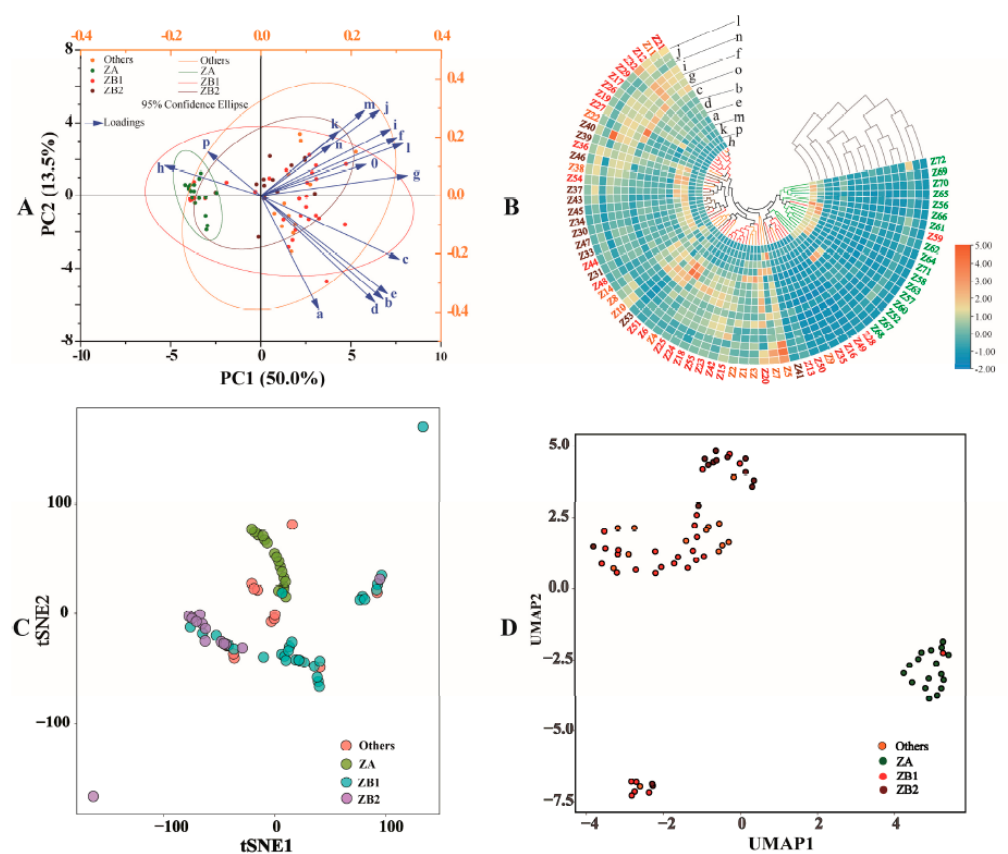
Figure 2. Geographical differentiation of prickly ash pericarps from 72 plantations based on the volatile oil profile of pericarps: ( A ) principal component analysis, ( B ) cluster heat map, ( C ) t-distributed stochastic neighbor embedding, ( D ) uniform manifold approximation and projection for dimension reduction. Sample codes or spots with the same colors represent the samples that belong to the same group; PC, principal component; ZA, samples with green pericarps ( n = 17) derived from species of Z. armatum ; ZB1, samples with red pericarps represented by Hancheng ( n = 29) derived from species of Z. bungeanum ; ZB2, samples with red pericarps represented by Fengxian ( n = 13) derived from species of Z. bungeanum ; others, samples with red pericarps, a clade of several species ( n = 13), not derived from species of Z. bungeanum ; tSNE, t-distributed stochastic neighbor embedding; UMAP, uniform manifold approximation and projection for dimension reduction; a, sabinene; b, alfa-myrcene; c, D-limonene; d, alfa-pinene; e, alfa-ocimene; f, gamma-terpinene; g, terpinolene; h, linalool; i, terpinen-4-ol; j, terpineol; k, linalyl acetate; l, alfa-terpinyl acetate; m, geranyl acetate; n, caryophyllene; o, beta-elemene; p, nerolidol.